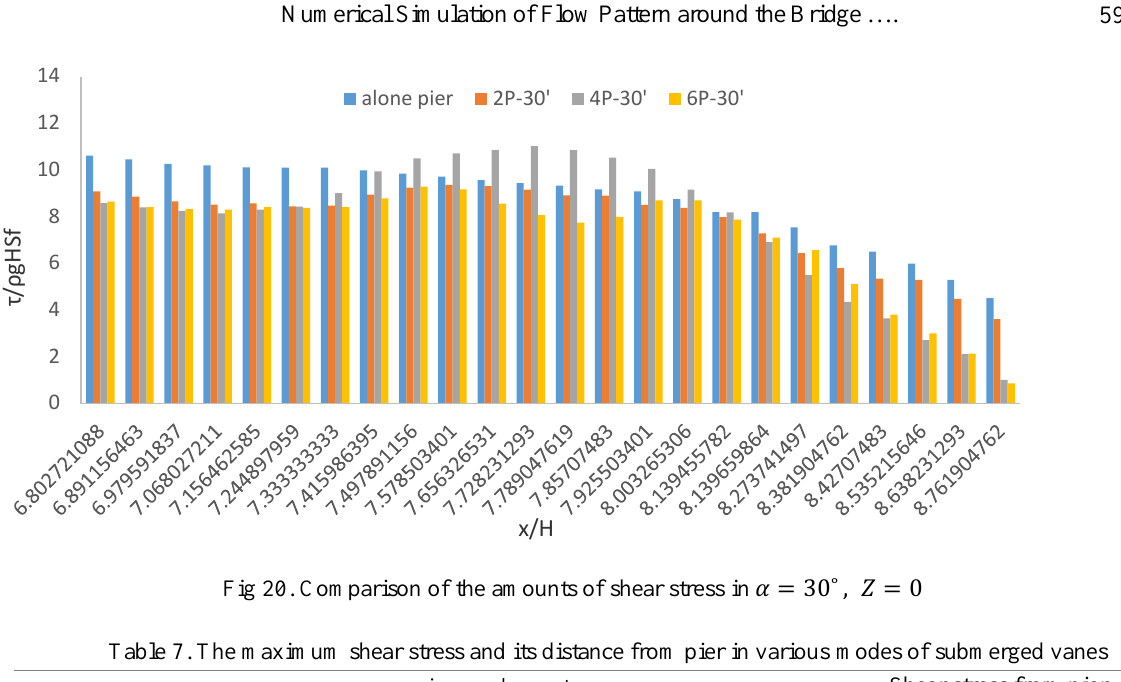
Shear stress from pier Distance from pier (m) ( 𝑵 ) 𝒎 𝟐